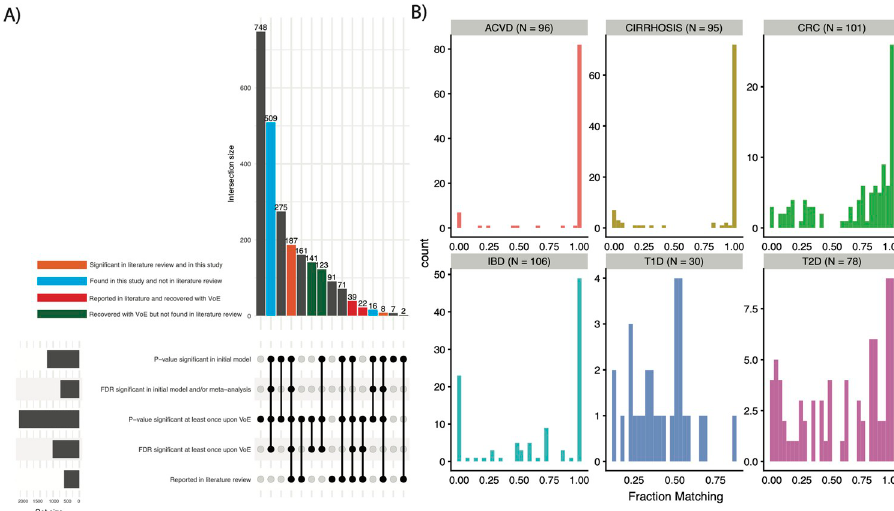
Fig 2. Comparing single modeling approaches to modeling VoE. (A) Stratifying features by their being identified in our literature review, p -value/FDR significant ( < 0.05) in our initial analysis, or having at least 1 significant model upon vibrations. The gray bars labeled “set size” indicate the number of features associated with a given row in the bottom of the plot (e.g., about 1000 features were p -value significant in the initial model). The gray bars in the upper portion of the panel are those we chose not to highlight, as they do not fall into any category indicated by the colors or referenced in the manuscript. (B) Distribution of fraction of models matching literature review–defined direction of associations. This figure can be generated using the code deposited in https://github.com/chiragjp/ubiome_robustness and the data deposited in https://figshare.com/projects/Microbiome_robustness/127607. ACVD, atherosclerotic cardiovascular disease; CRC, colorectal cancer; FDR, false discovery rate; IBD, inflammatory bowel disease; T1D, type 1 diabetes; T2D, type 2 diabetes; VoE, vibration of